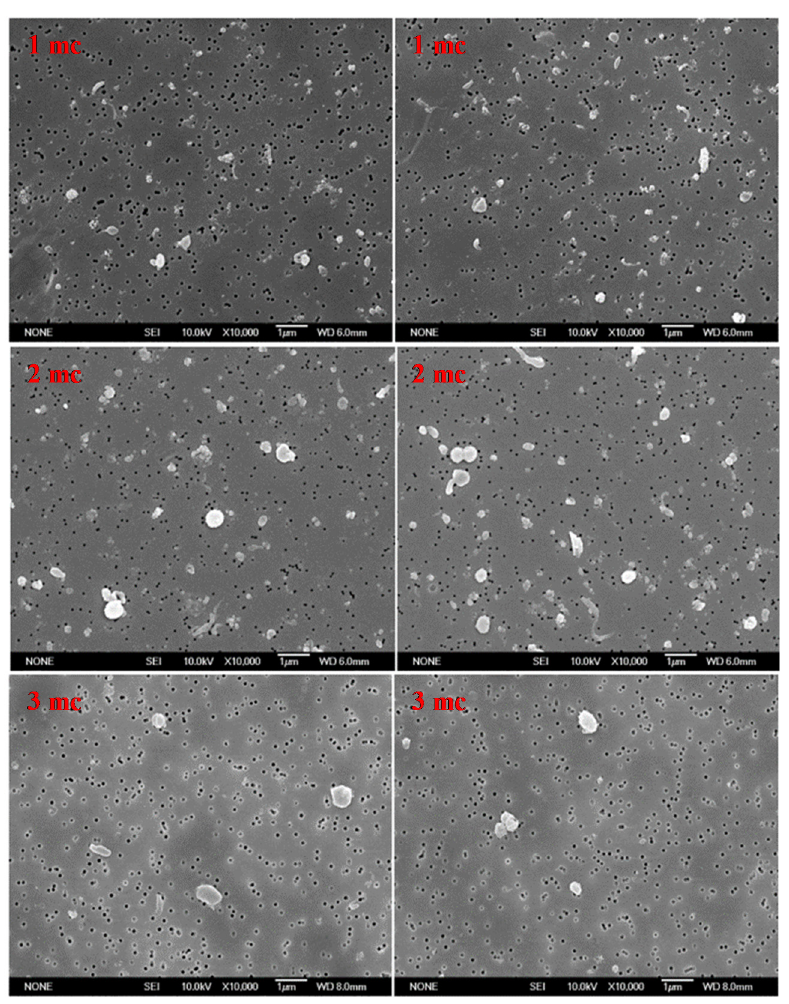
Figure 2. Two SEM images captured after 1million, 2 million and 3 million cycles. mc: million cycles. The quantity of HXLPE-DG particles presented on the filter membrane after every mil- lion cycles are shown in Figure 3. The results showed that the number of wear particles in- creased when going from one million cycles (3.48 × 10 8 particles/mL ± 4.36 × 10 7 particles/mL) to two million cycles (4.99 × 10 8 particles/mL ± 3.89 × 10 7 particles/mL ) , but then reduced to 3.35 × 10 8 particles/mL ± 3.53 × 10 7 particles/mL when measured at three million cy- cles ( p < 0.001). The total number of wear particles across the three million cycles was 1.18 × 10 8 ± 1.18 × 10 7 , with the content of wear particles in the calf serum medium being 3.94 × 10 8 particles/mL ± 3.93 × 10 7 particles/mL.